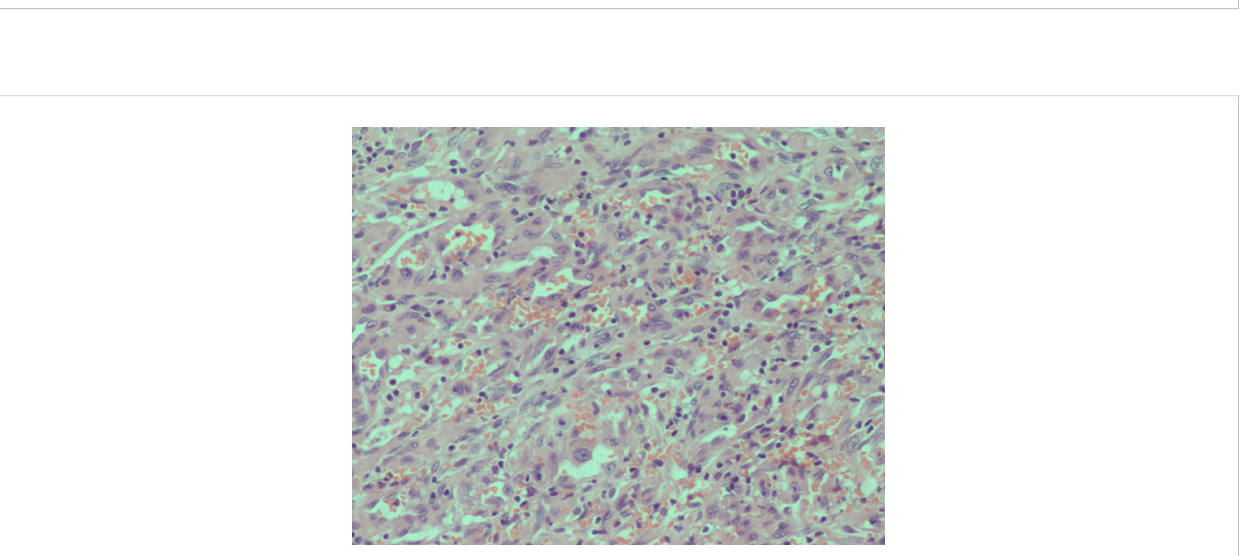
FIGURE 5 Histopathology of the resected mass. High-power magni fi cation (200×) shows cords and groups of epithelioid cells in a dense without well-formed vascular structures.